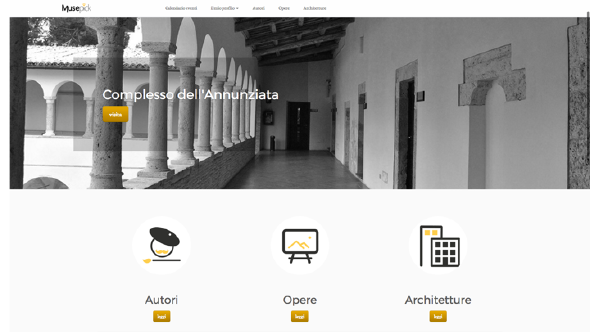
Figure 11. Home page of the web portal